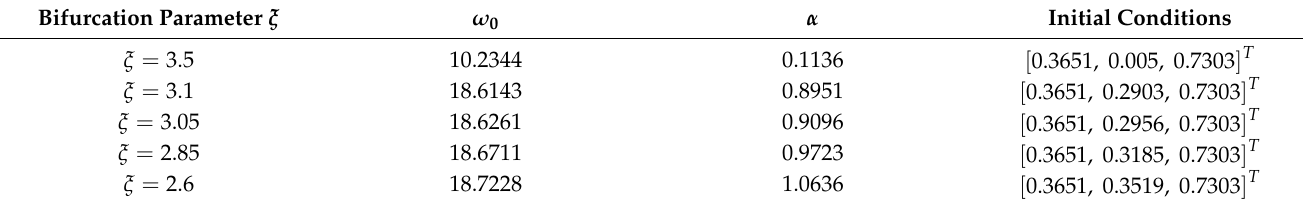
Table 1. Calculations of the initial conditions for locating hidden oscillations in the MAVPD system